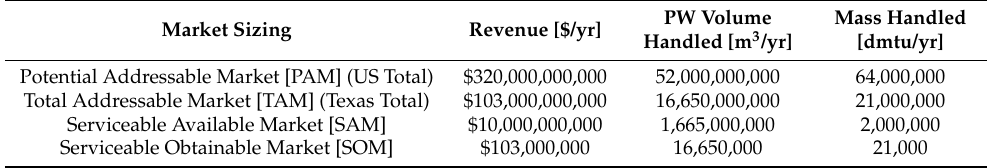
Table 5. Potential market